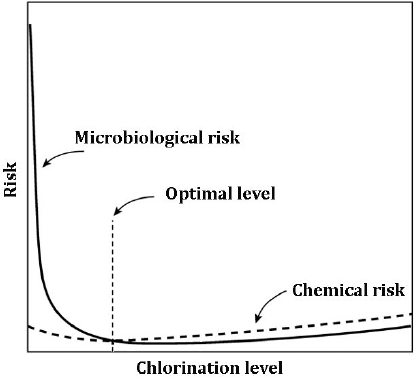
Figure 1. Relationship between chlorination level and associated risk, adapted from [7].